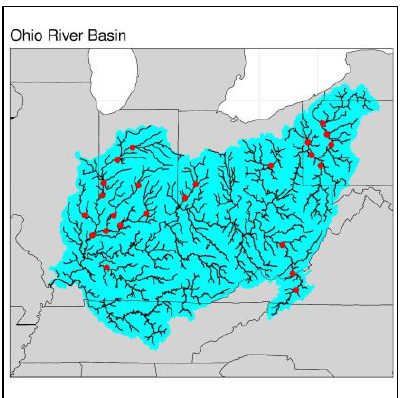
Figure 1. The Ohio River Basin domain (shaded in blue). The red dots denote the stations used in this study.